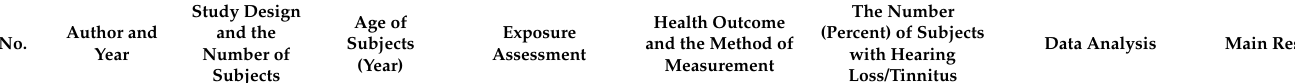
Table 4. Results of individual studies fulfilling the inclusion